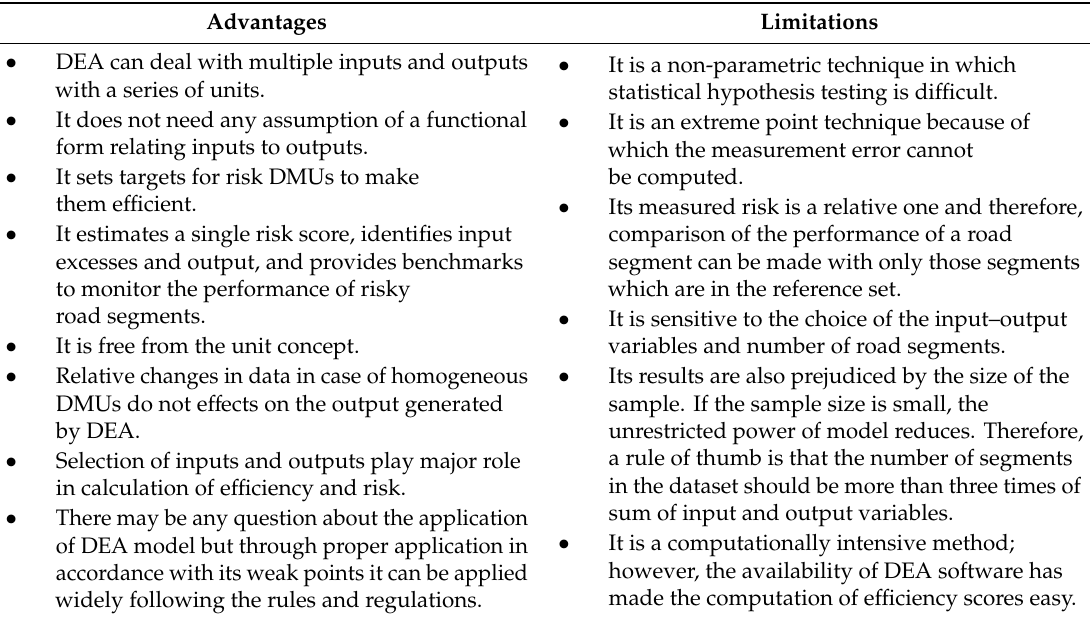
Table 4. Advantages and limitations of using the DEA